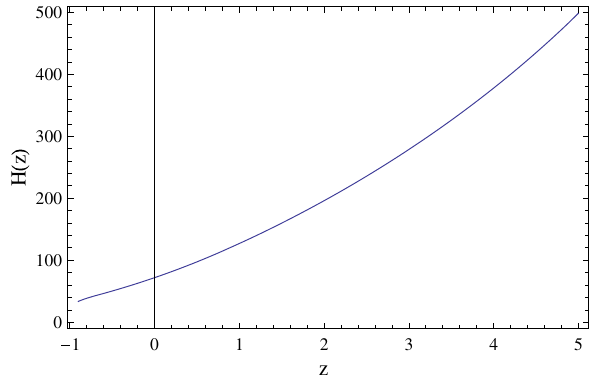
Fig. 2 Variation of H ( z ) with the variation of z (Model I) by consid- ering the best fit values w 0 = − 0 . 737 ,w 1 = 0 . 173